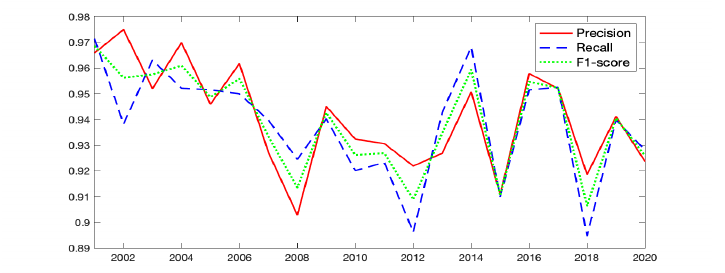
Figure A8. The time series of precision, recall, and F1-score parameters of the 2 × 2 confusion matrix for Model-1c.